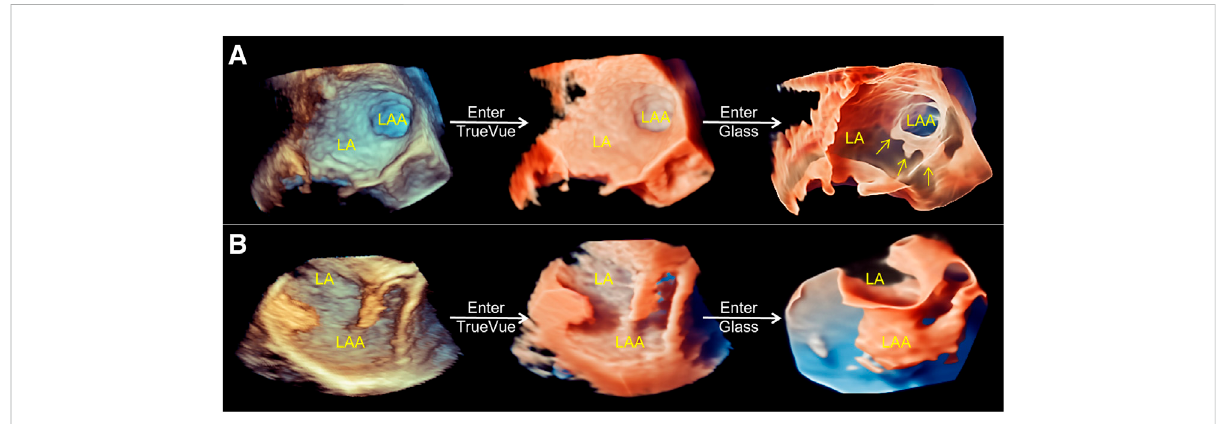
FIGURE 1 Schematic of process of the conversion of conventional real-time 3D transesophageal echocardiography to TrueVue Glass. (A) . From left to right, conventional3D, TrueVueand TrueVue Glassimagingmodes oftheLAAattheentrance oftheleftatriumareshown. TheTrueVueGlass (right) showsthethreelobularstructuresattheblindendoftheLAA(arrows) (B) .Fromlefttoright,conventional3D,TrueVueandTrueVueGlassimagingof the LAA in lateral view are shown. 3D, three-dimensional; LA, left atrium; LAA, left atrium